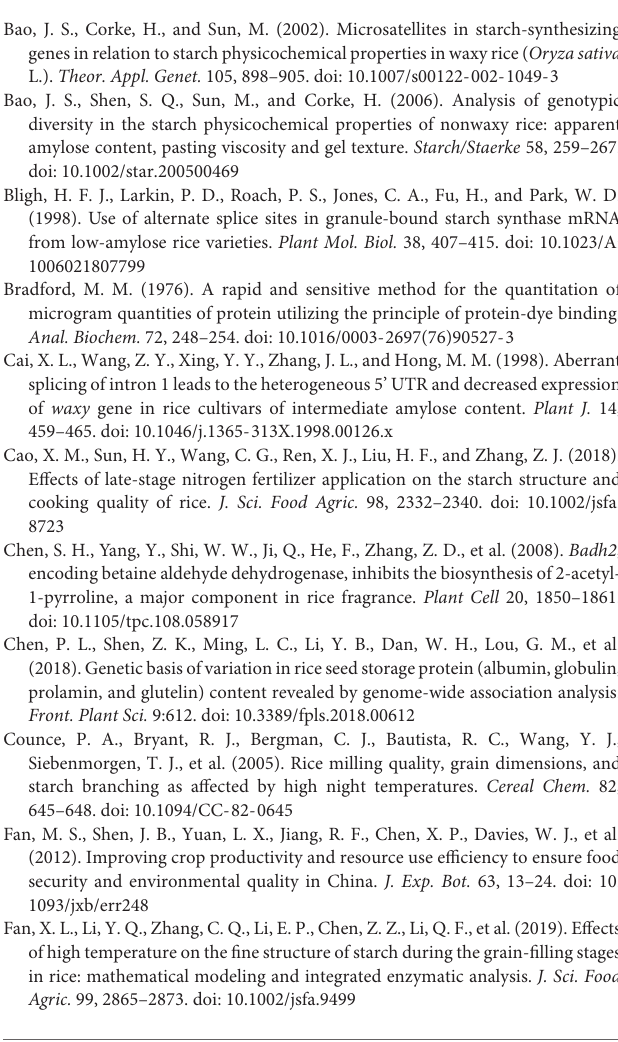
Supplementary Figure 1 | Appearance. (A) Cooked rice of Nipponbare Wx NILs; (B) grain of Zhennuo Wx transformants at high and low temperatures; (C) grain of